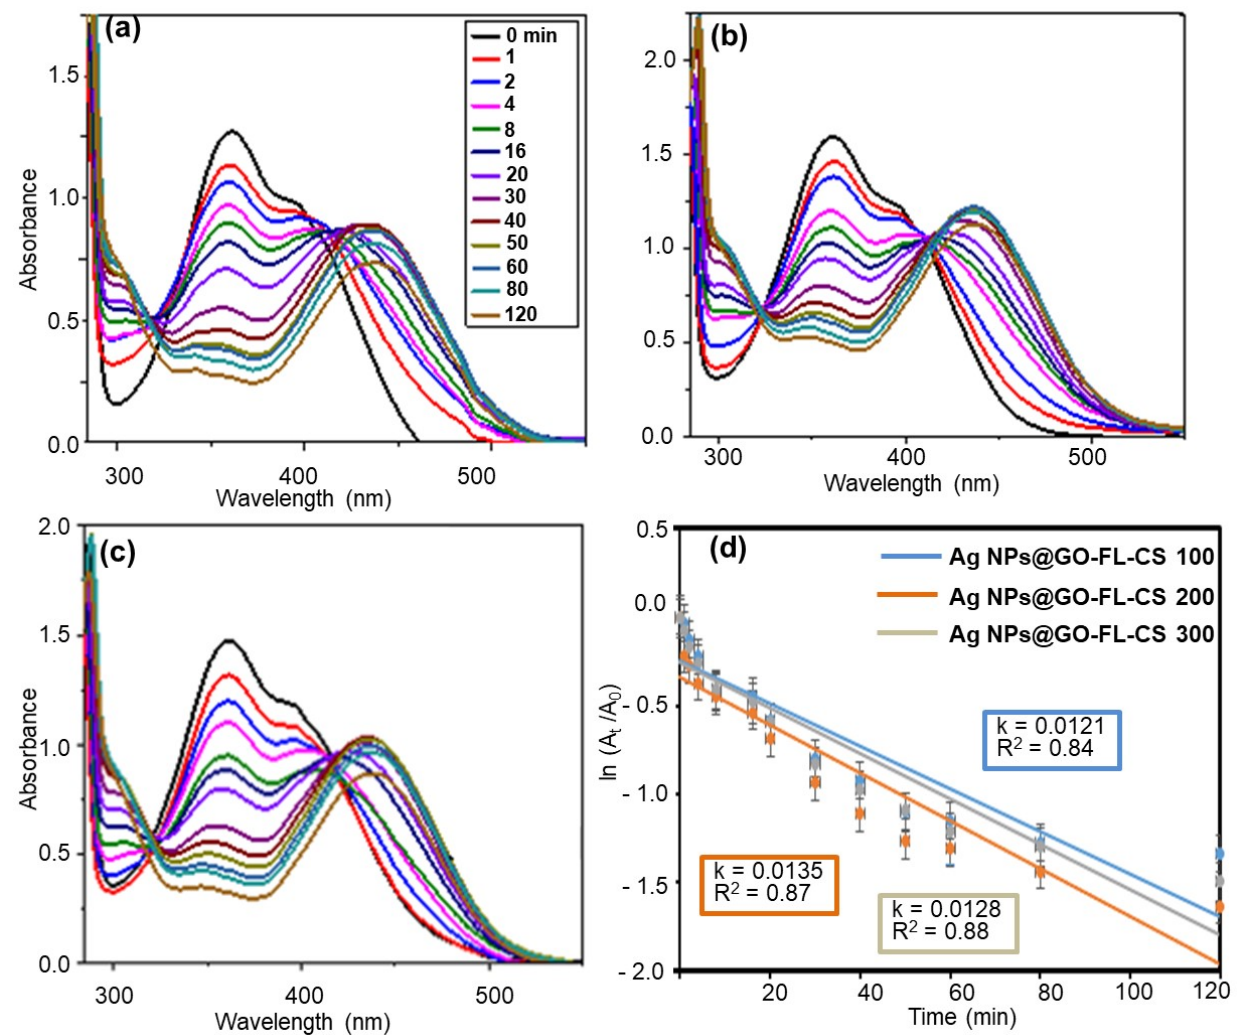
Figure 7. UV-Vis absorption spectra for the reduction of 2,4-DNP over ( a ) Ag NPs@GO-FL-CS 100, ( b ) Ag NPs@GO-FL-CS 200, and ( c ) Ag NPs@GO-FL-CS 300; ( d ) The corresponding kinetics graphs. The error bars denote standard deviations obtained from three trials.